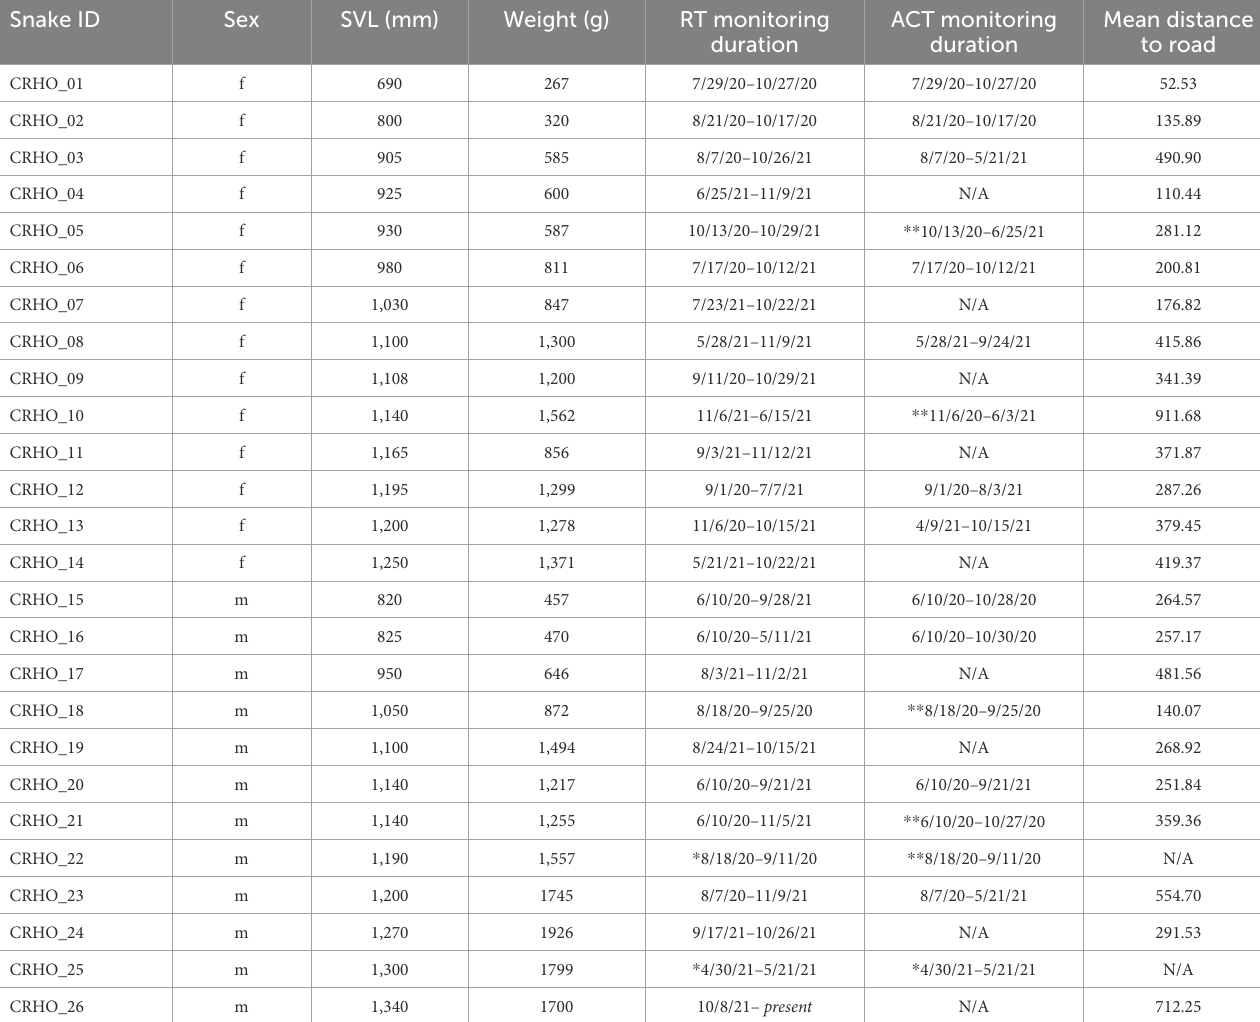
TABLE 1 Snake ID, sex, Snout-Vent Length (SVL), weight, RT monitoring durations, and ACT monitoring durations for all Crotalus horridus monitored. Snake